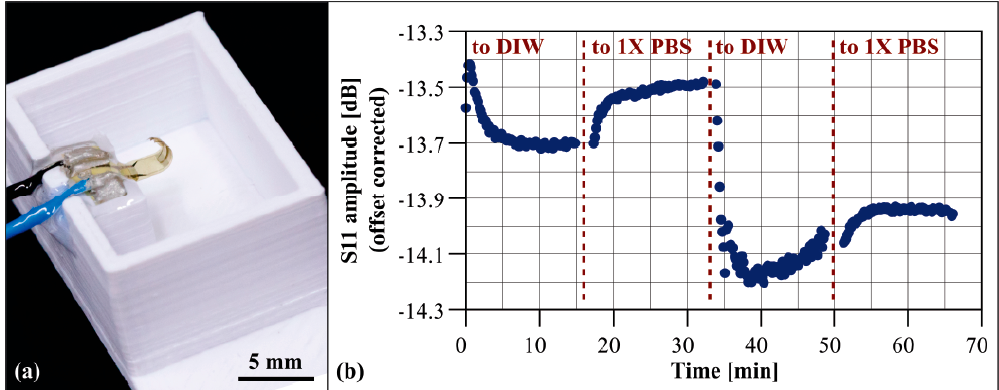
Figure 2. ( a ) Test set up for polyimide sensors (not immersed in solution for better visibility), ( b ) electrical sensor response for varying ionic strength in surrounding solution (alternated between de- ionized water (DIW) and phosphate-buffered saline (1X PBS)) (from data previously published in [11]). The measured signal is the reflective coefficient (S11 parameter) obtained with a network analyzer at a frequency of 163.5 MHz. A slight offset induced through the liquid exchange has been